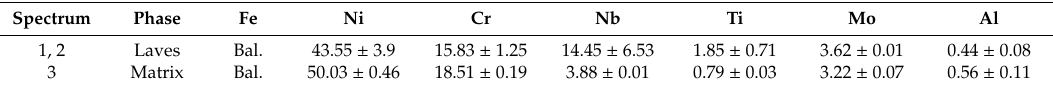
Figure 4. SEM micrograph of the non-etched as-printed laser powder bed fused IN718 superalloy: ( a ) vertical plane (xz); ( b ) horizontal plane (xy). Table 3. EDS spot analysis results of the as-printed condition in Figure 5